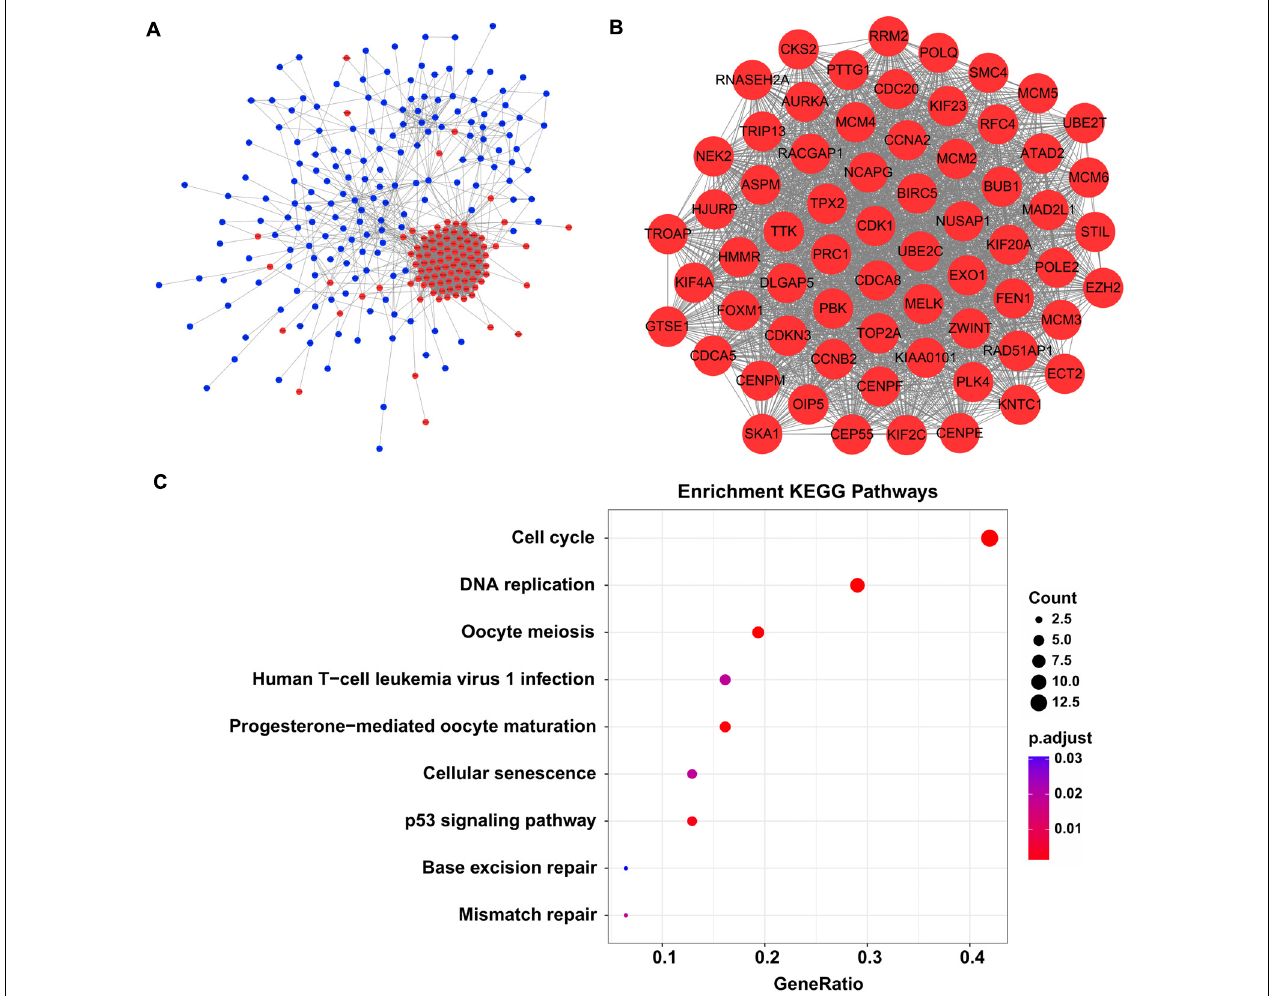
FIGURE 3 | The liver carcinogenesis-related module and its biological functions. (A) Liver carcinogenesis-related network. The internal interactions between DEG pairs were mined using STRING database and the network was visualized using Cytoscape software. Red nodes signify upregulated genes and blue nodes indicate downregulated genes. The edges between any two nodes represent internal interactions. (B) Liver carcinogenesis-related module. Members in this module are highly connected. All the modular genes were upregulated in HCC tissues. (C) Significantly enriched KEGG pathways of the modular genes. ClusterProfiler package was selected to perform functional specification. Adjusted P -values of < 0.05 were considered statistically